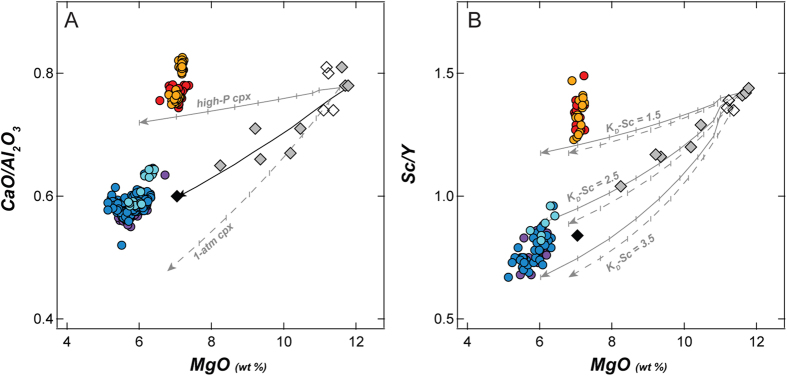
Role of clinopyroxene in crystal fractionation.Symbols as in Figs 2, 3. A) CaO/Al2O3 versus MgO. Black arrow shows major-element fractionation model of Furman et al.27, of ~48% fractionation of the approximate assemblage cpx (47%) > ol (27%) > plag (20%) > mgt (6%), with stepwise-calculated equilibrium mineral compositions. Grey arrows show (in 5% increments) fractionation of the same assemblage but with measured ol + plag (Supplementary Table S1), mgt26, and the high-P (>10 kbar, solid) and 1-atm (dashed) experimental cpx compositions from Thy22. B) Sc/Y versus MgO. Solid and dashed arrows calculated as in A, but showing influence from the range of possible KDSc in cpx for alkali basalts4748.